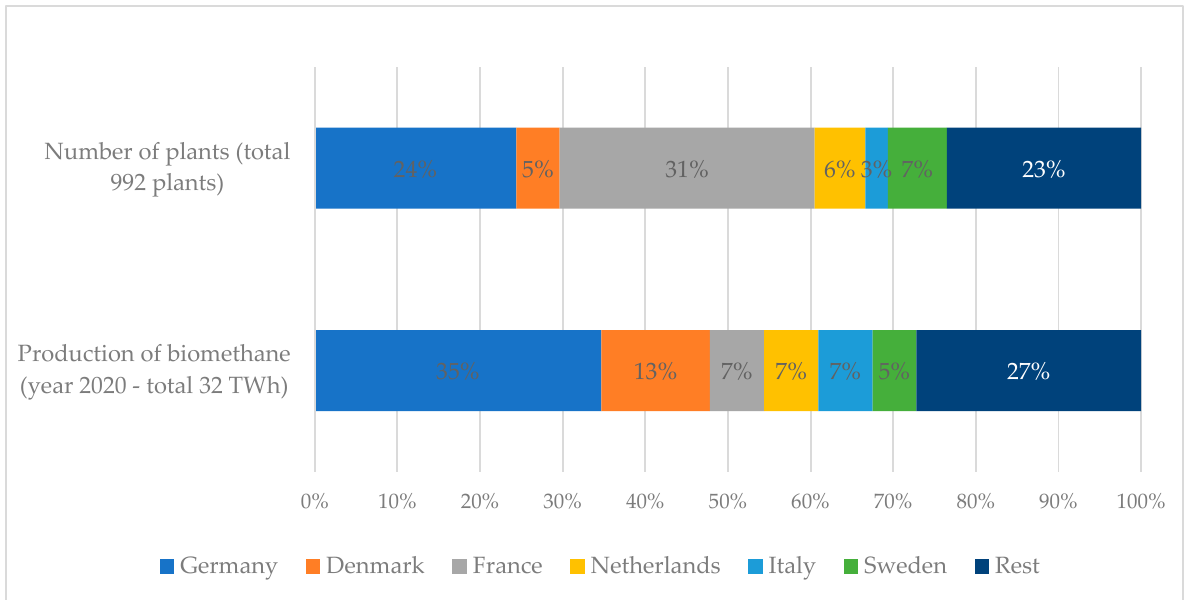
Figure 4. Number of biomethane plants and biomethane production in the EU (2011–2020). Source: EBA [82].